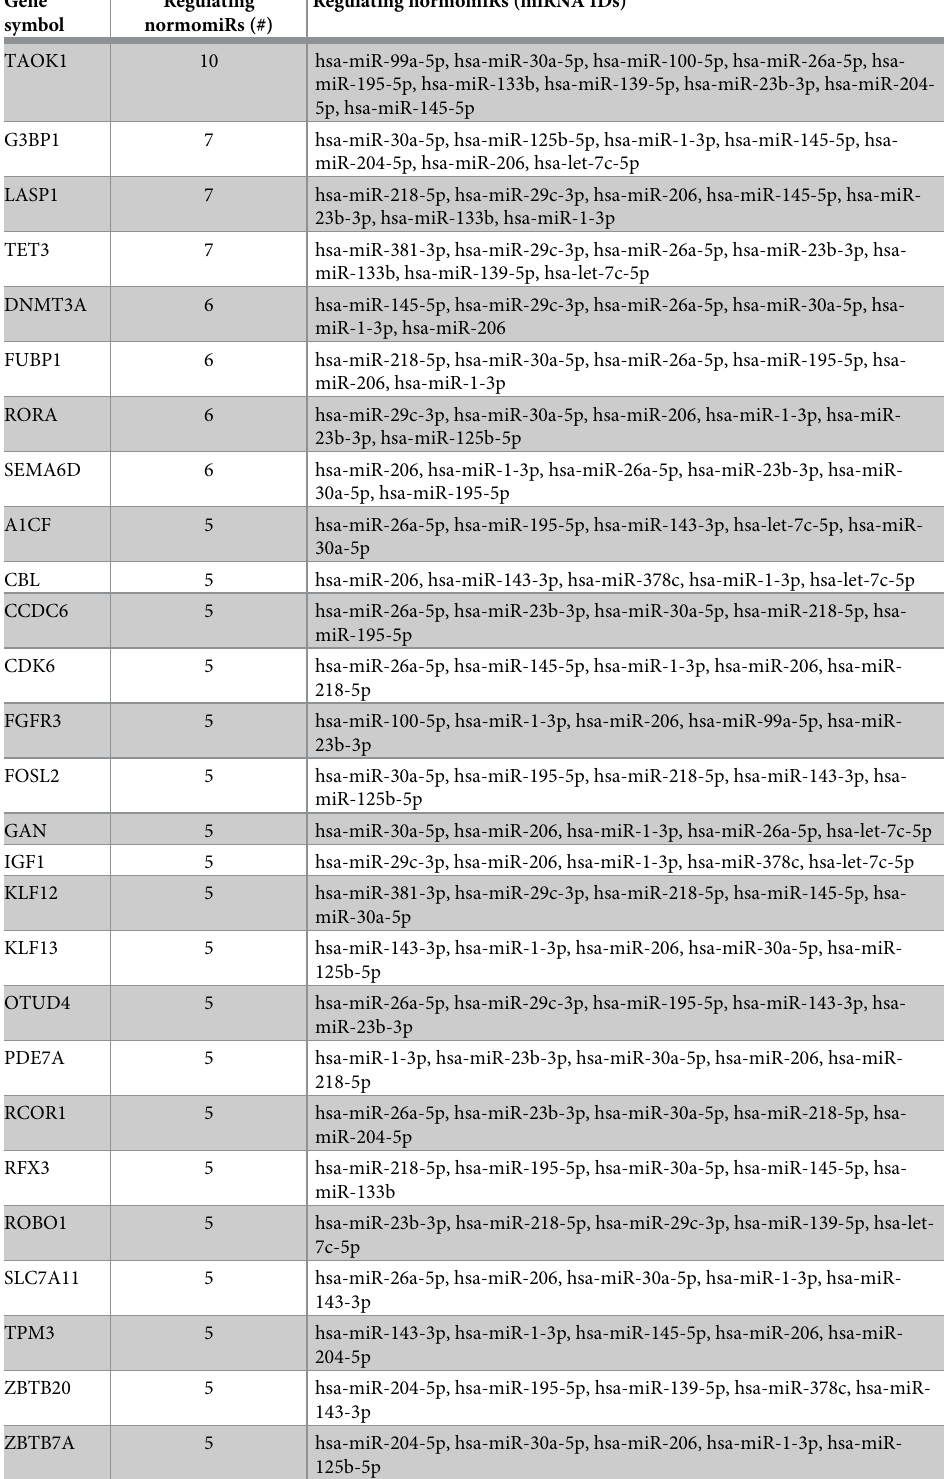
Table 1. The oncogenes predicted to be co-targeted by several normomiRs in various cancer